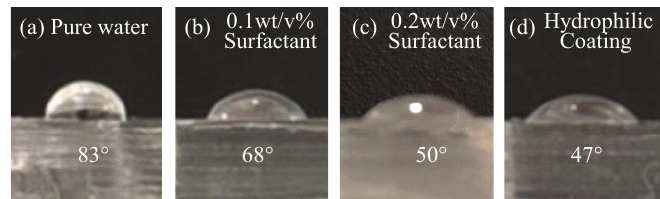
Figure 9. Contact angles for four materials: ( a ) pure water on polydimethylsiloxane(PDMS), ( b ) 0.1 wt/v% surfactant solution on PDMS, ( c ) 0.2 wt/v% surfactant solution on PDMS, and ( d ) pure water on PDMS coated by the hydrophilic